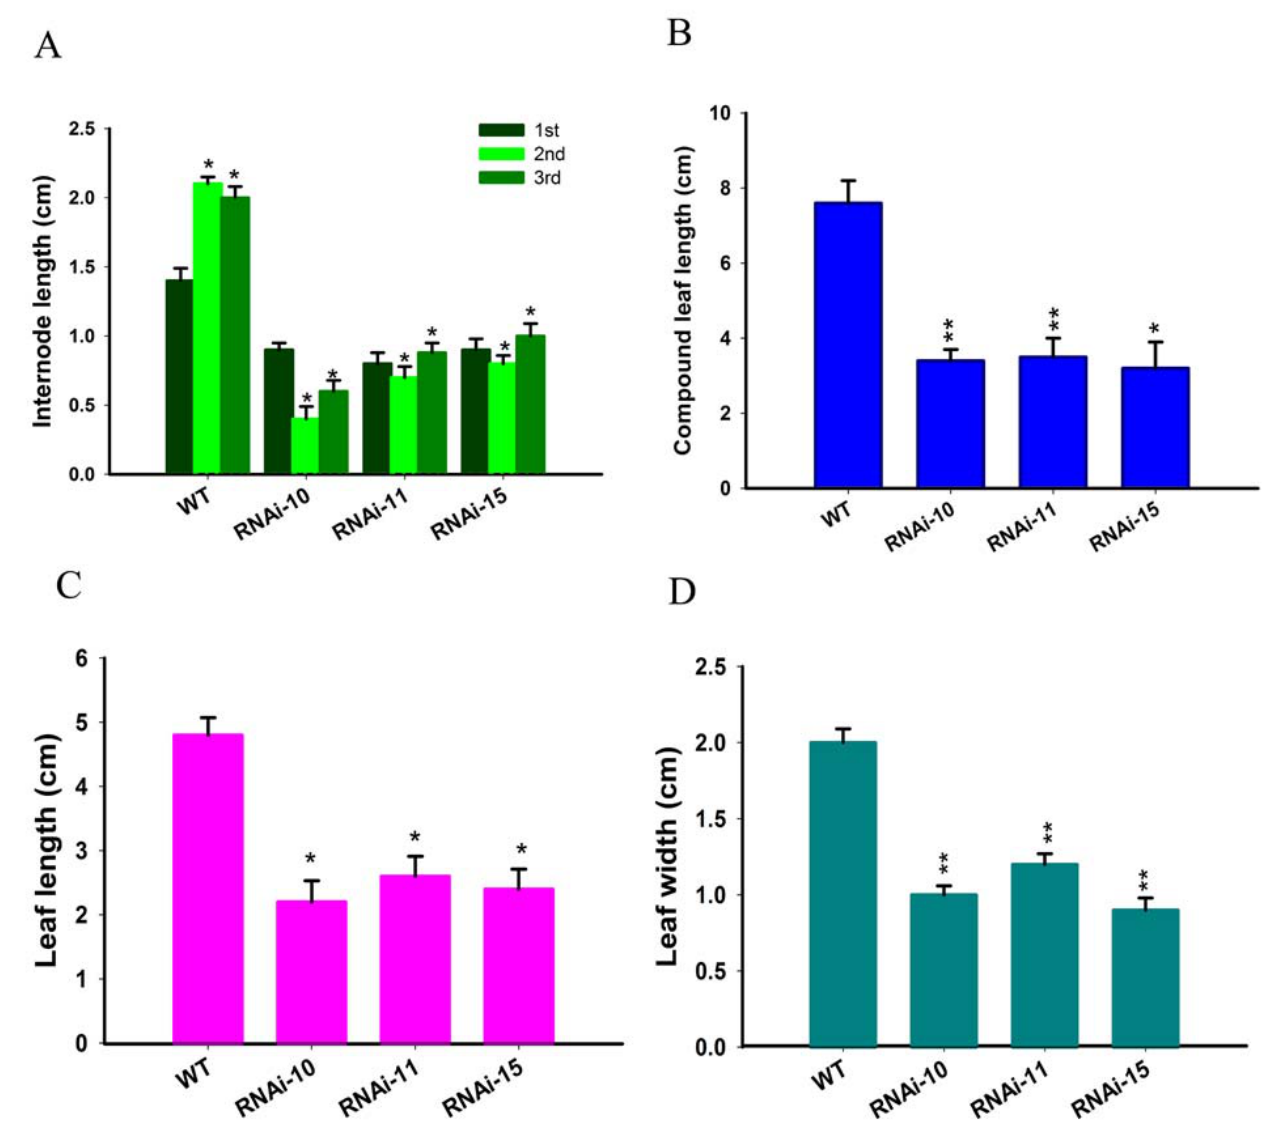
Figure 4. Down-regulation of SlGRAS10 decreased leaf size and internode length. ( A ) Internode length of the first to third nodes from about 35-days-old SlGRAS10 -RNAi transgenic and wild-type plants. ( B ) The total mature compound leaf length of SlGRAS10 -RNAi and wild-type plants. ( C ) The length of the apical leaflet from the mature compound leaves from transgenic and wild-type plants. ( D ) The width of the apical leaflet from the mature compound leaves from transgenic and wild-type plants. The date represents the mean ± SE of three independent replicates ( n = 15). *, ** indicates a significant difference ( p < 0.05, p < 0.01) between transgenic and wild-type plants.